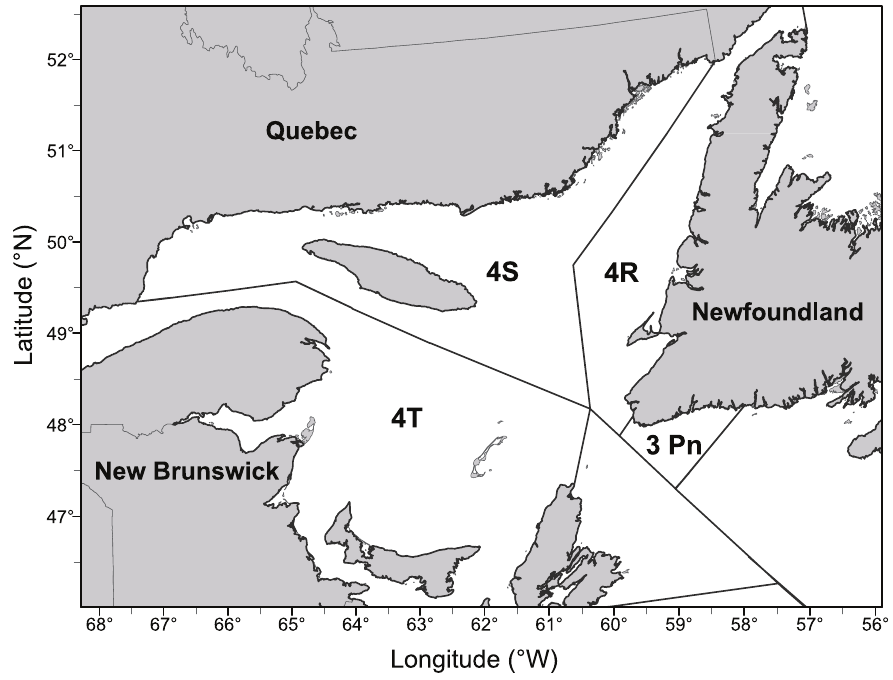
Figure 1. Northern Gulf of Saint Lawrence (NAFO divisions 4R and 4S).